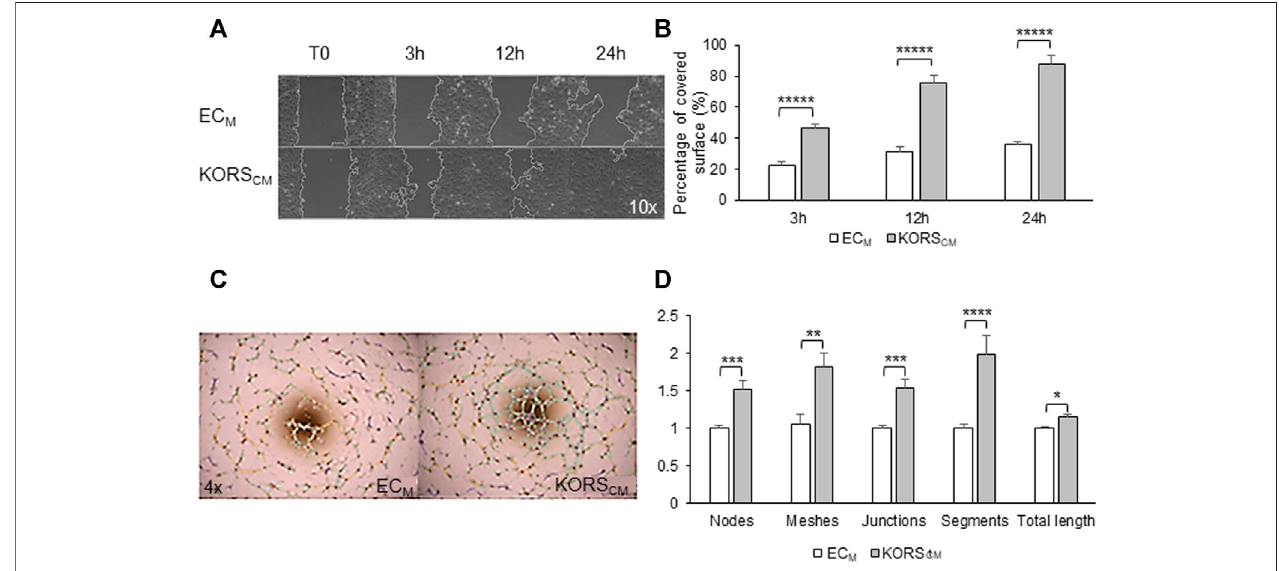
FIGURE 5 | Angiogenic effect of KORS CM on HDMEC. (A,B) The migration of HDMECs in the EC M or KORS CM is shown (A) and quanti fi ed as the percentage of recovery (B) . The results are expressed as the mean ± SEM, n (cid:2) 3 replicates and three fi elds were analyzed per replicate, two independent experiments. (C,D) HDMEC pseudotube formation after 5 h in EC M or KORS CM is illustrated (C) and the number of nodes, meshes, junctions, segments, and the total length were calculated and expressed as the mean ± SEM, n (cid:2) 8 replicates and three independent experiments (D) .